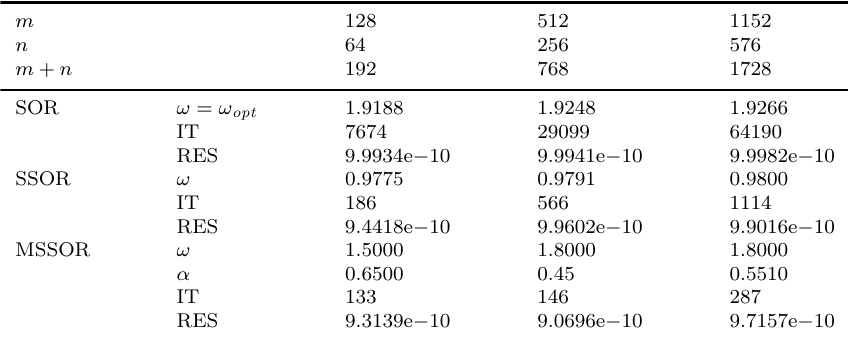
Table 2. The optimum parameters, IT and RES for this example when Q = B T B ( τ = 1). m 128 512 1152 n 64 256 576 m + n 192 768 1728 SOR ω = ω opt 1.9188 1.9248